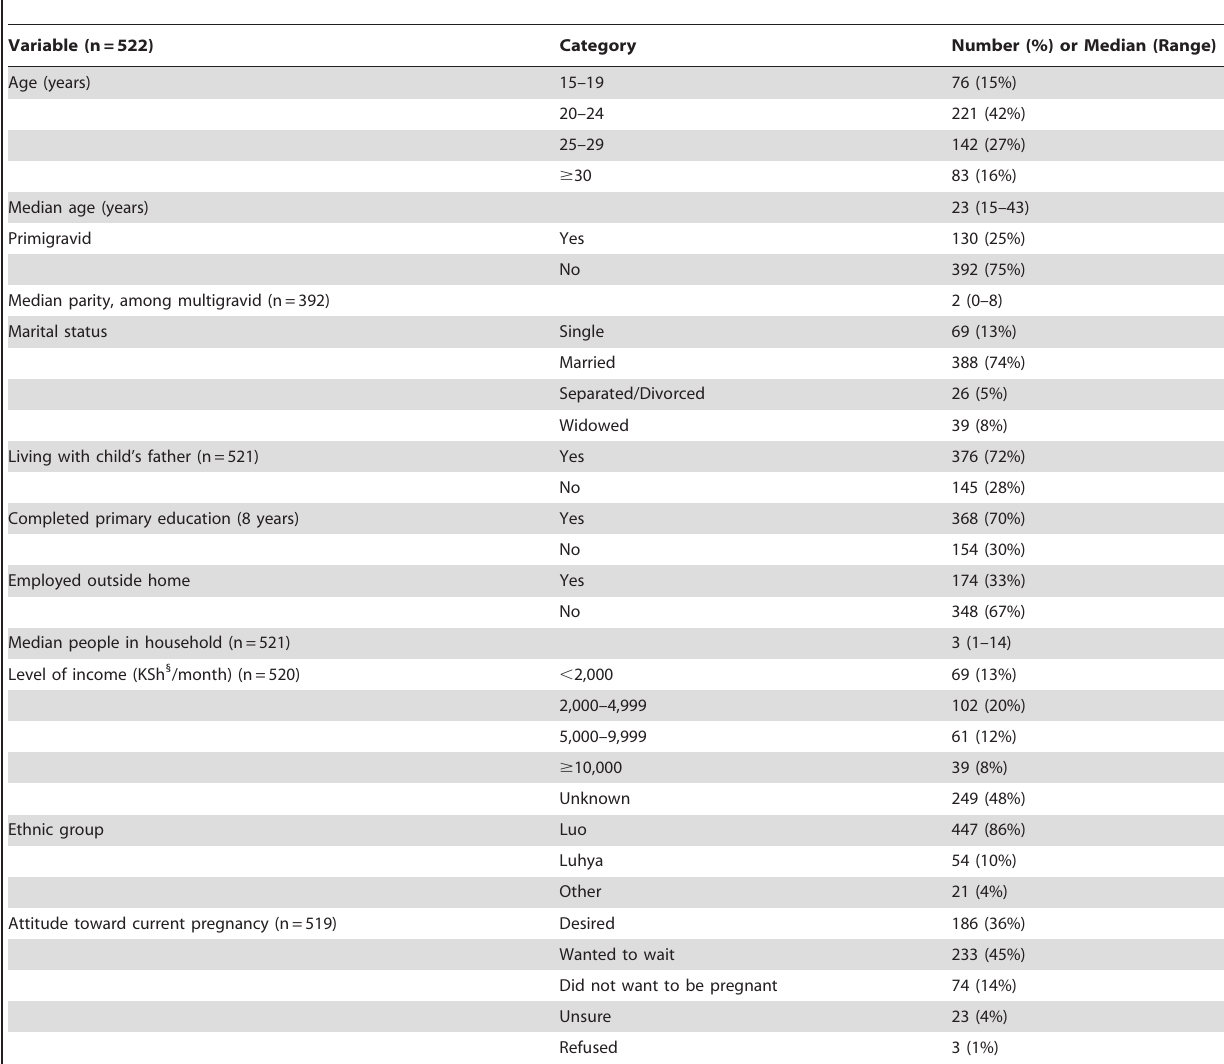
Table 1. Baseline Maternal Characteristics of 522 HIV-Infected Women Initiating ARV Therapy for PMTCT in the Kisumu Breastfeeding Study, July 2003 to November